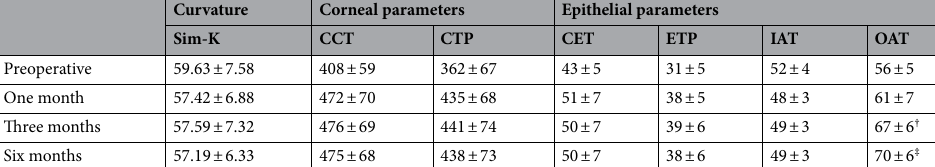
Curvature Corneal